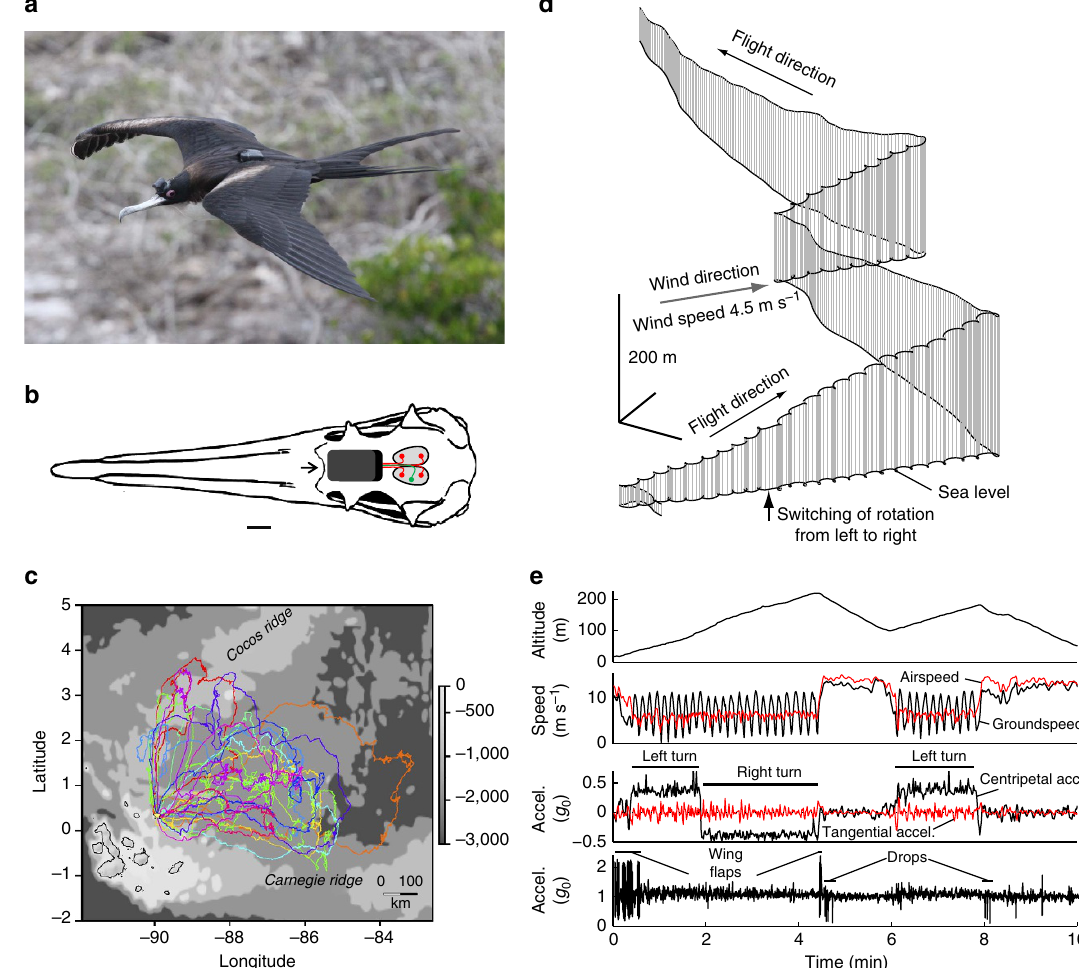
Figure 1 | Measuring the brain state and flight mode of flying frigatebirds. ( a ) Great frigatebird with a head-mounted data logger for recording the electroencephalogram (EEG) from both cerebral hemispheres and head acceleration in three dimensions. A back-mounted GPS logger recorded position and altitude. Photo: B.V. ( b ) Overhead view of a great frigatebird skull showing (1) the position of the cranial bulge (shaded grey) overlying the hyperpallium of each hemisphere, (2) the position of the epidural electrodes (red dots, EEG; green dot, ground) and (3) the data logger (black rectangle) just posterior to the naso-frontal hinge (arrow). Scale bar is 10 mm. ( c ) All GPS tracks for individual birds coded with different colours. The Galapagos Islands are outlined with black lines and the study site (Genovesa) is marked by a star. Ocean depth (m) is coded with grey scale. ( d ) High temporal resolution (1Hz) 10min flight trajectory recorded with GPS from a frigatebird (see Supplementary Movie 1 for 3D visualization) showing the circling (soaring) and straight (gliding) flight modes typical of Fregatidae 13 (Methods). ( e ) Altitude, ground speed and airspeed (computed from the GPS data in ( d )), tangential and centripetal (radial) low-pass filtered acceleration, and the absolute value of total acceleration (measured by an accelerometer) for the flight in ( d ). NATURE COMMUNICATIONS|7:12468|DOI: